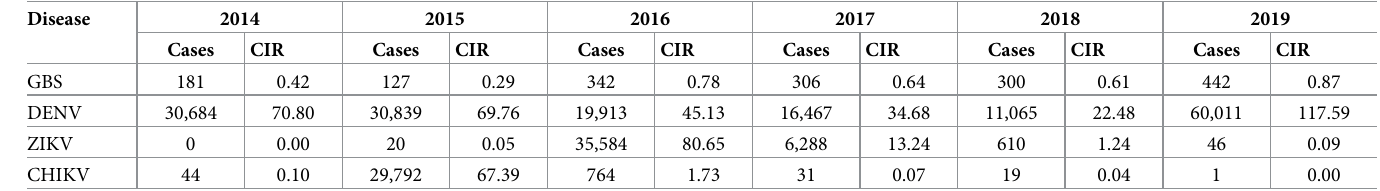
Table 1. Number of cases and cumulative incidence rate � of GBS, DENV, CHIKV and ZIKV, Mexico IMSS 2014–2019.